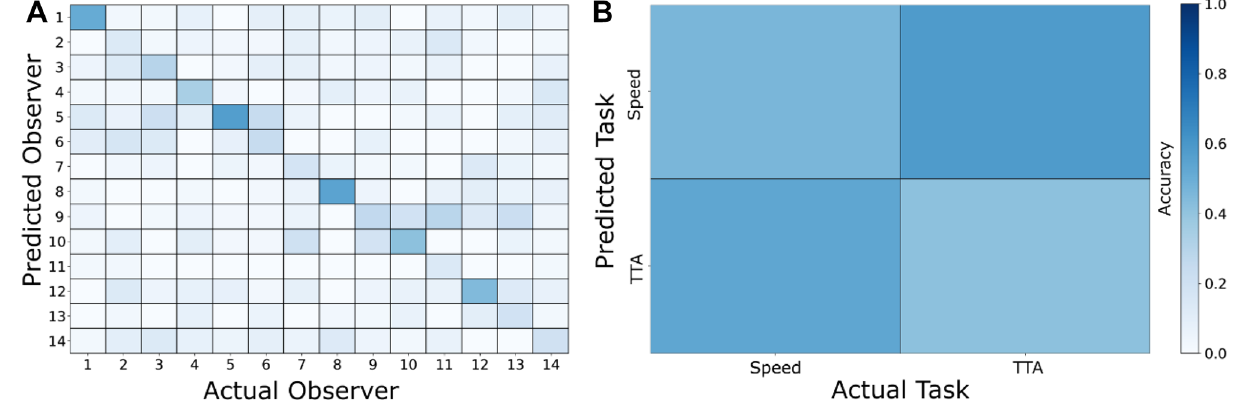
Figure 6. Confusion matrices of SVM predictions. ( A ) Shows the observer classification performance. ( B ) Shows the task classification